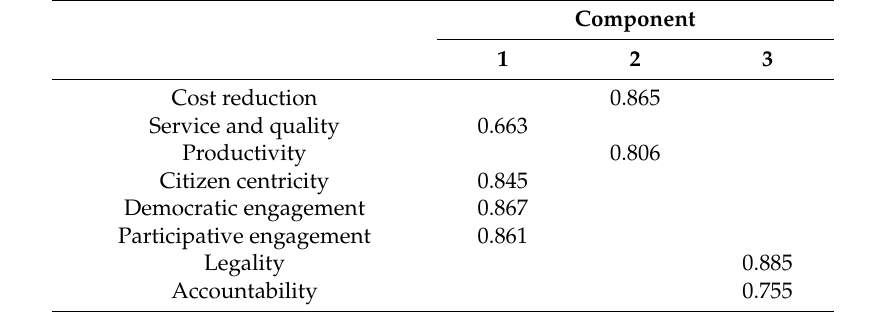
Table 14. Rotated component matrix a